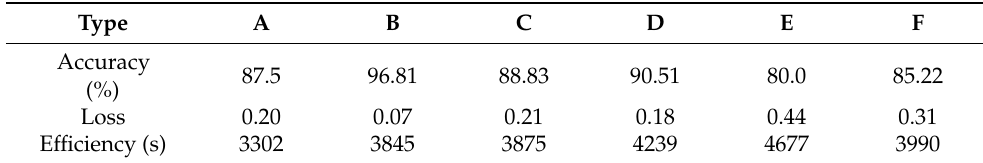
Table 4. Evaluation results of MCNN6 on six types of